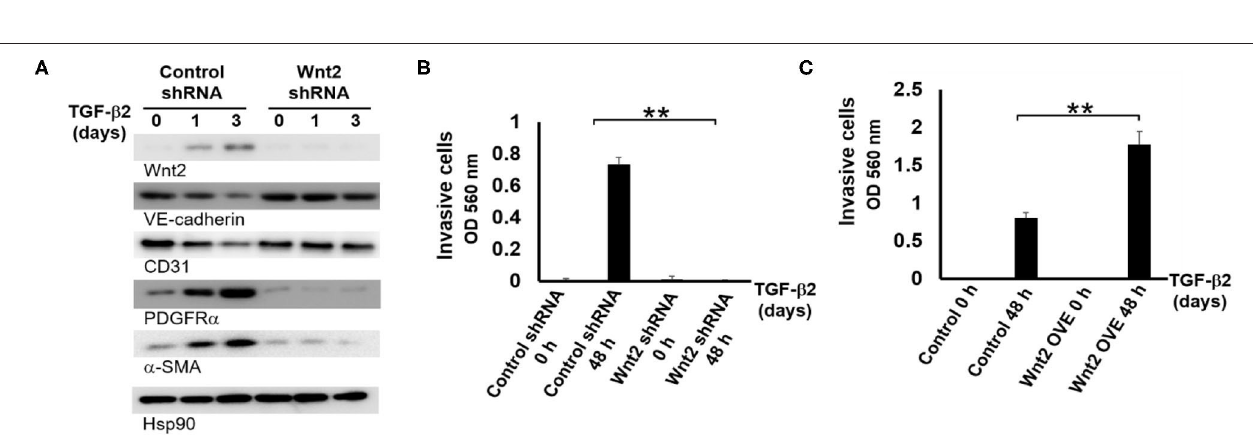
FIGURE 4 | Wnt2 is required the TGF- β 2 mediated-EndMT in cells migration and invasion. (A) HAECs stably transfected with control scrambled shRNA and Wnt2 shRNA were treated with TGF- β 2 over time as indicated in the figure. Then, the WCLs were subjected to WB analysis. VE-cadherin, CD31, PDGFR α , and α -SMA. Hsp90 expression was used as a loading control. Experiments were repeated three times. (B) The comparison of invasive capabilities between control and Wnt2 shRNA with TGF- β 2 treatment HAECs in the indicated time. Each value represents the mean ± SD. n = 3, ** P < 0.01 (C) The comparison of invasive capabilities between control and Wnt2 overexpression (OVE) with TGF- β 2 treatment HAECs in the indicated time. Each value represents the mean ± SD. n = 3, ** P < 0.01. (D ) Immunoblotting analysis of the EndMT markers in Wnt4 KD, Wnt10B KD, and Wnt11 KD HAECs with or without TGF- β 2 treatment for 3 days, respectively. WCLs collected from KD cells treated with TGF- β 2 for 0 and 3 days were subjected to immunoblots using the indicated antibodies. Hsp90 protein level is used as a loading control. Experiments were repeated three